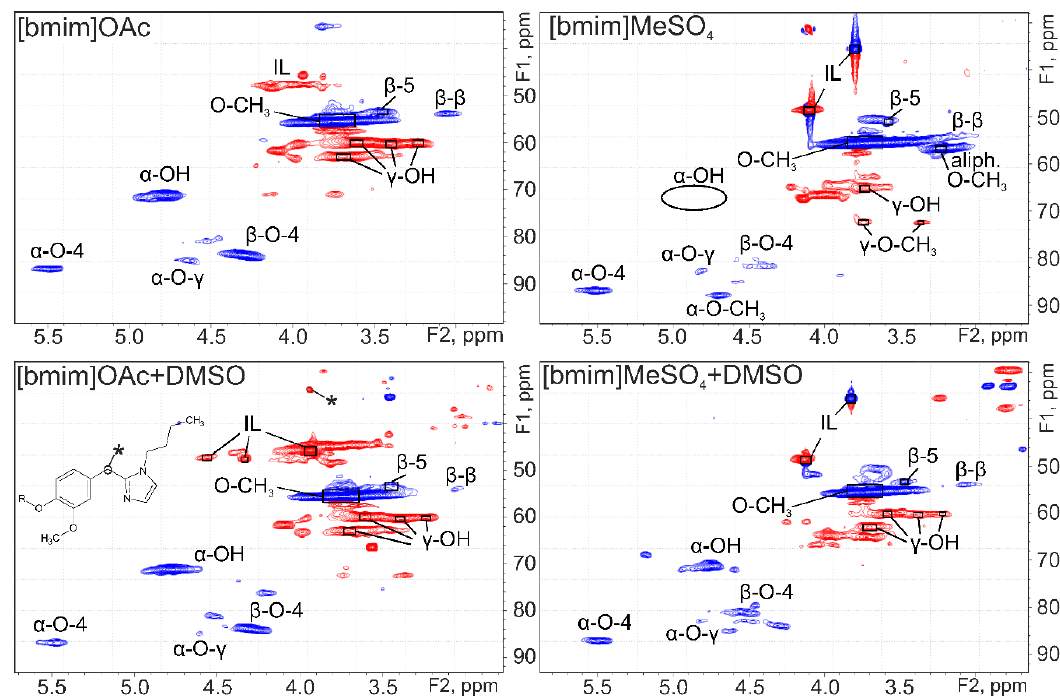
Figure 3. 2D NMR spectra (HSQC) of IL lignins (aliphatic structures region). Table 4. Contents of the main types of inter-unit bonds in lignins (number per 100 aromatic units). Sample